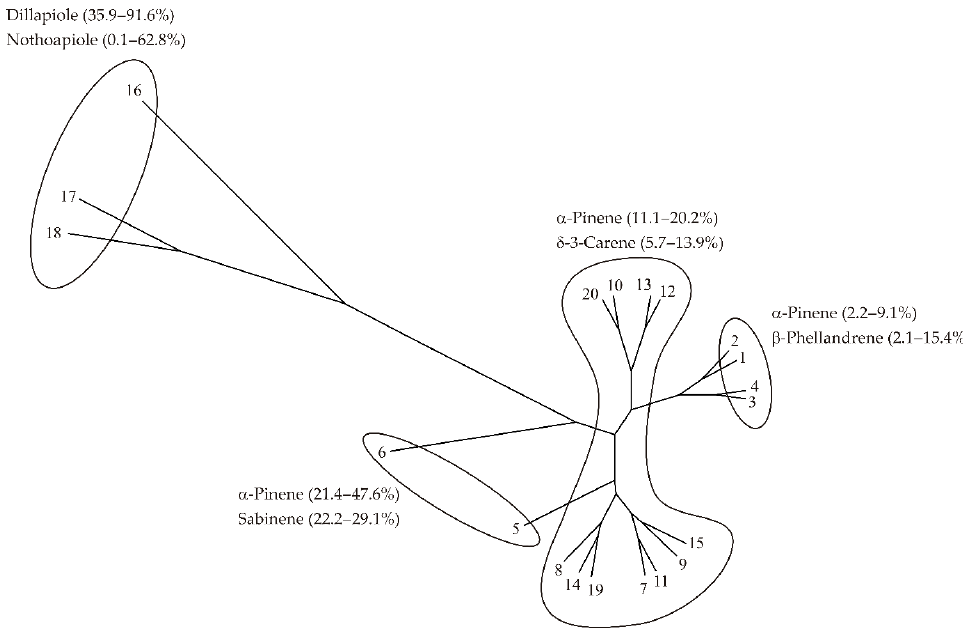
Figure 3. Unrooted cluster tree of A. archangelica root essential oil (samples are numbered according to Table 1).